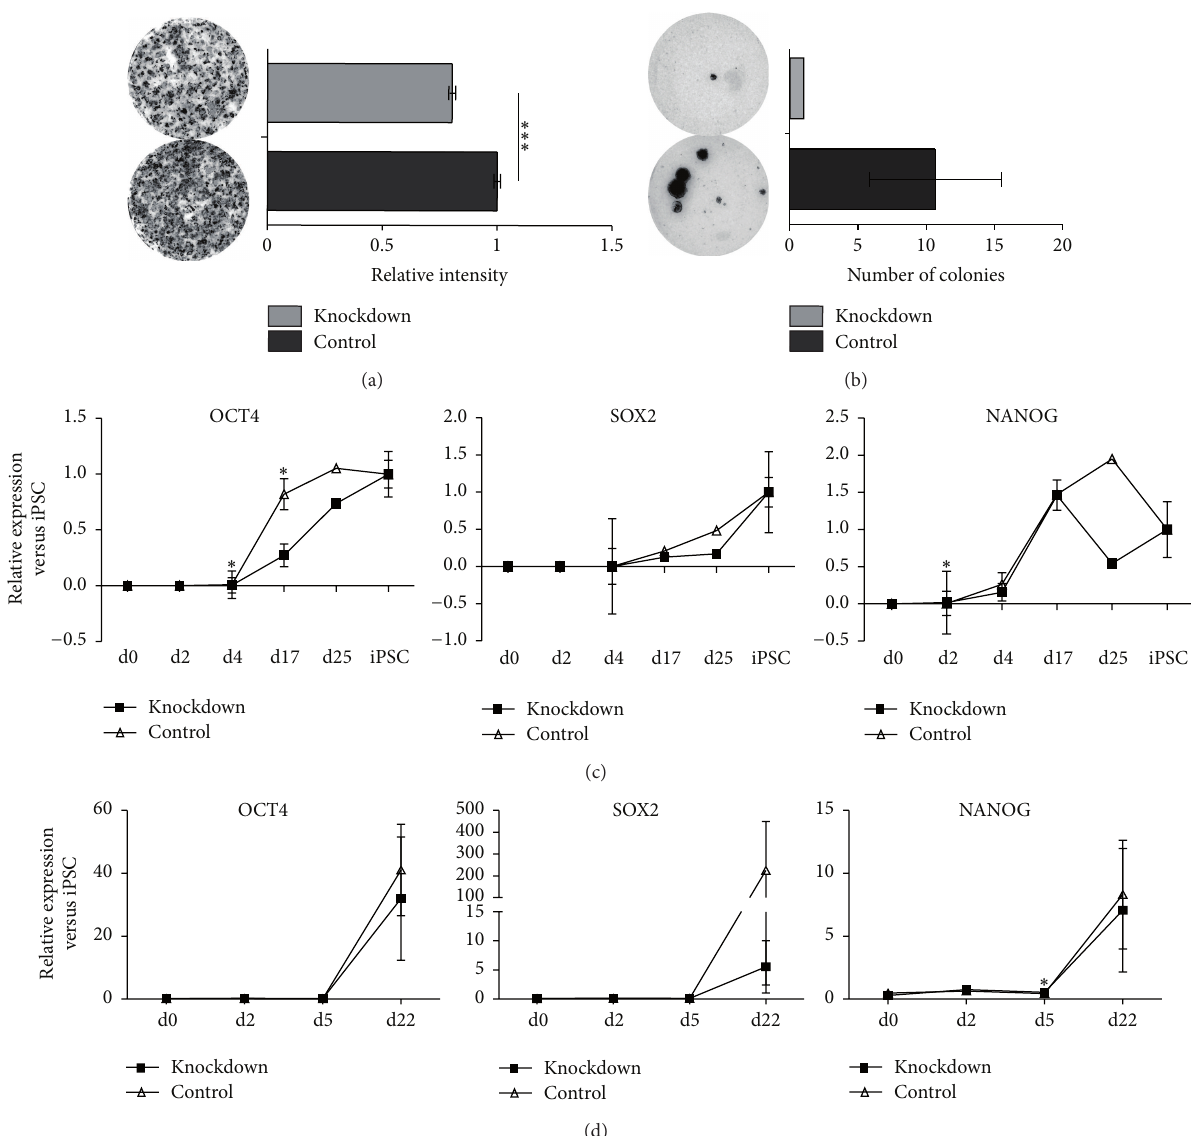
Figure 2: TBX3 knockdown in fibroblasts and keratinocytes during reprogramming causes decreased reprogramming efficiency. (a) Alkaline phosphatase (AP) staining at day 17 of fibroblast reprogramming with a highly significant reduction (23%) of iPSC colonies. (b) Alkaline phosphatase (AP) staining at day 22 of keratinocyte reprogramming with a reduction (91%) of iPSC colonies. (c) Relative expression of OCT4 , SOX2, and NANOG during fibroblast reprogramming. (d) Relative expression of OCT4, SOX2, and NANOG during keratinocyte